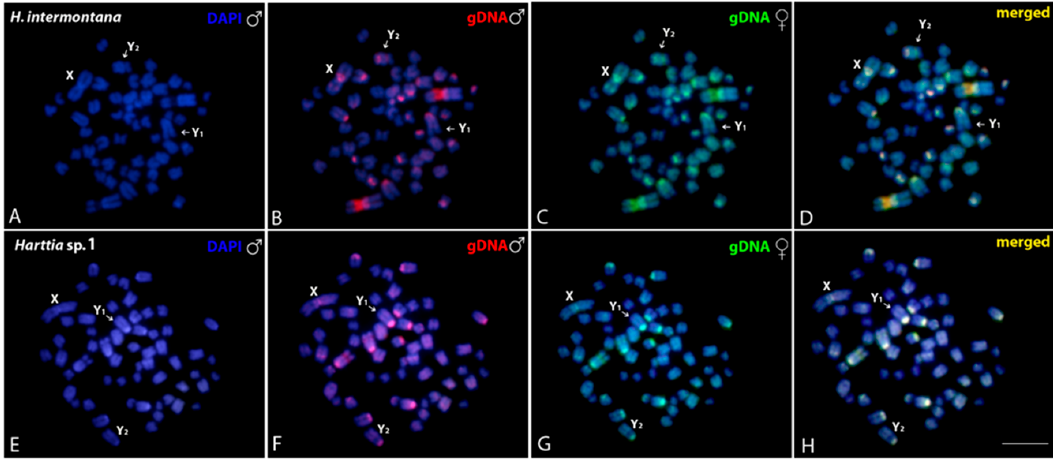
Figure 4. Mitotic chromosome spreads of males H. intermontana ( A – D ) and Harttia sp. 1 ( E – H ) after intraspecific genomic hybridizations, with male- and female-derived genomic probes hybridized together for each species. The first column ( A , E ): DAPI images (blue); Second column ( B , F ): hybridization pattern for the male-derived probe (red); Third column ( C , G ): hybridization pattern for the female-derived probe (green); Fourth column ( D , H ): merged images for both genomic probes and DAPI staining. The common genomic regions for males and females are depicted in yellow. Arrows indicate the sex chromosomes. Bar = 10 μ m.